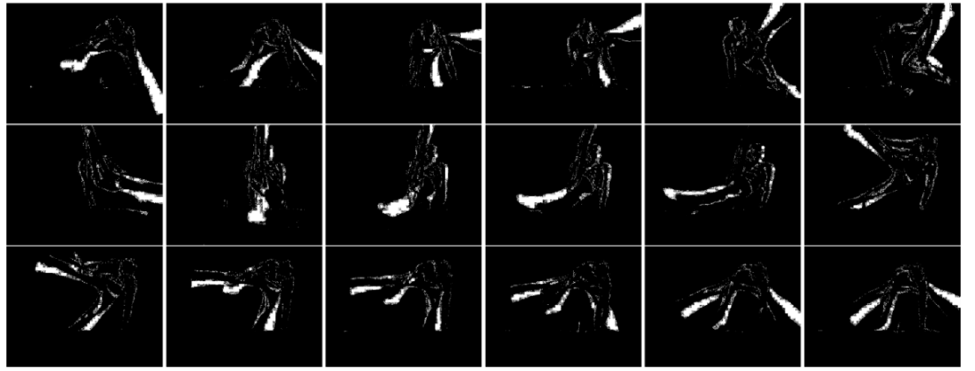
Figure 3. The Application of the Growth Function on Swing Activity.